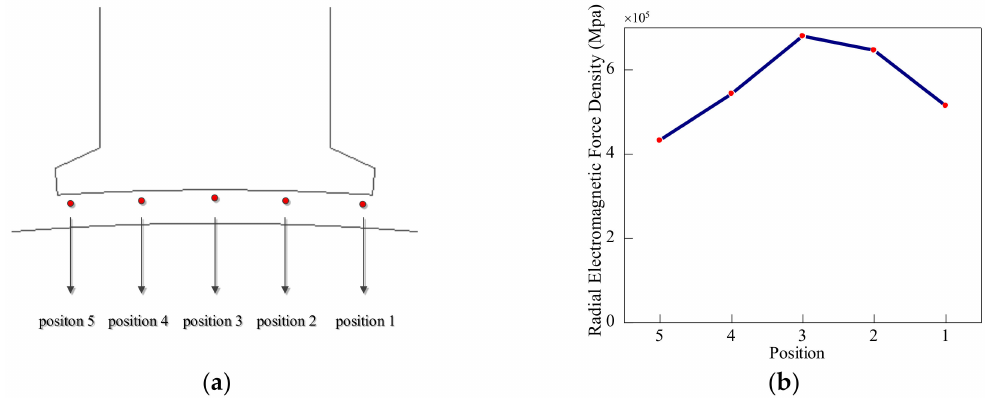
Figure 13. ( a ) Position of selected points on a stator tooth; ( b ) Radial electromagnetic force density of five selected points.